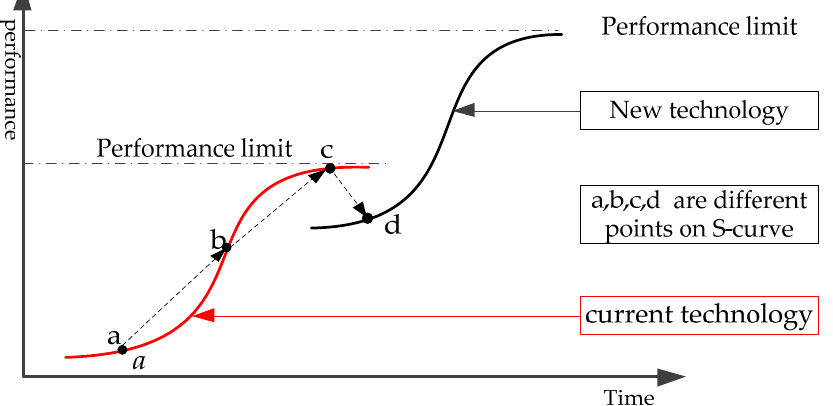
Figure 1. Parallel and serial technological competition preceding RI.